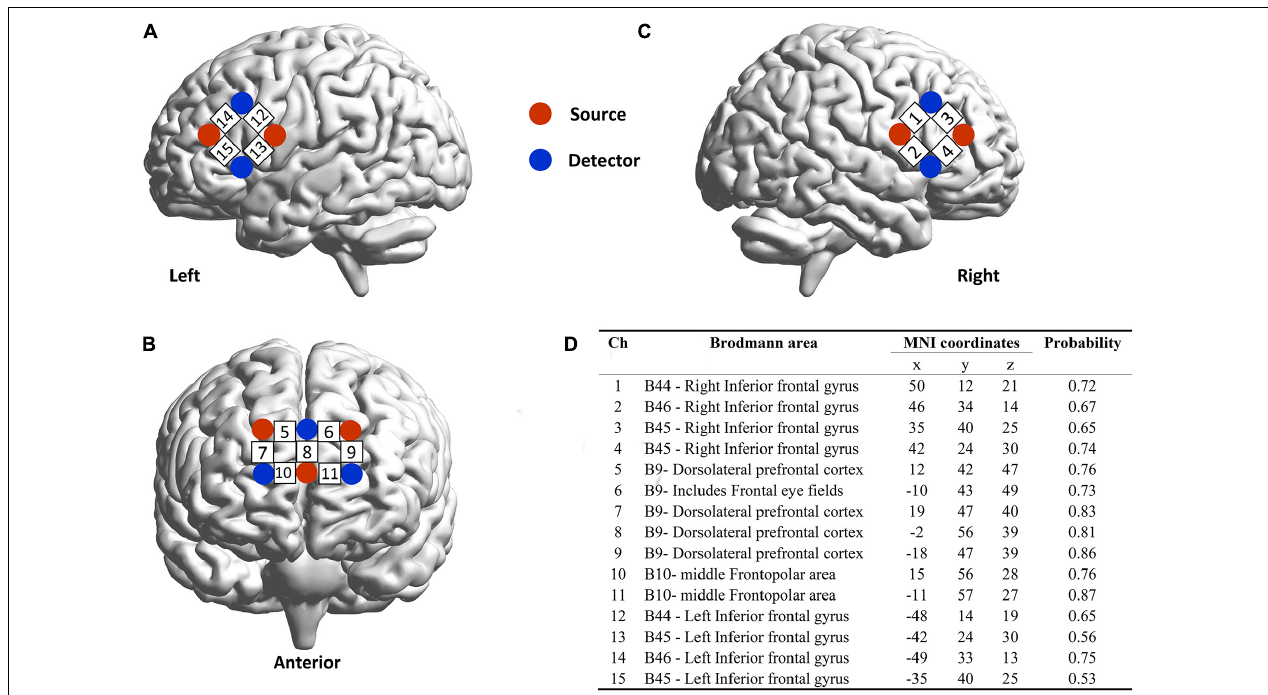
FIGURE 2 | Positions of functional near-infrared spectroscopy (fNIRS) channels. (A) front, (B) left, and (C) right view of fNIRS channels placed on one of the participants in the dyad. (D) The Montreal Neurological Institute brain spacing of fNIRS